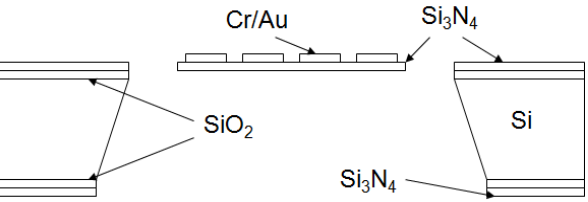
Figure 1. Cross-section of a finished bulk micromachined bridge or cantilever-type Pirani gauge.